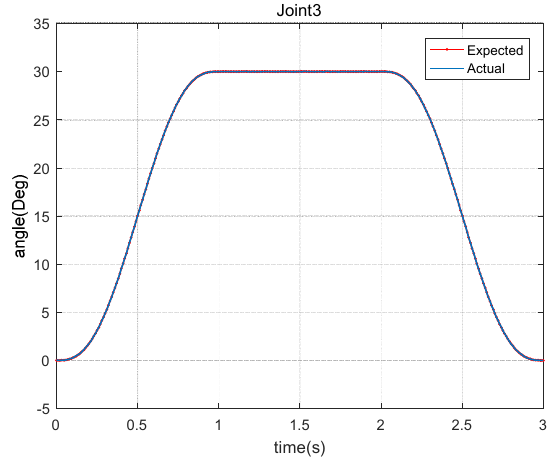
Figure 15. The motion of the root joint of arm 1.